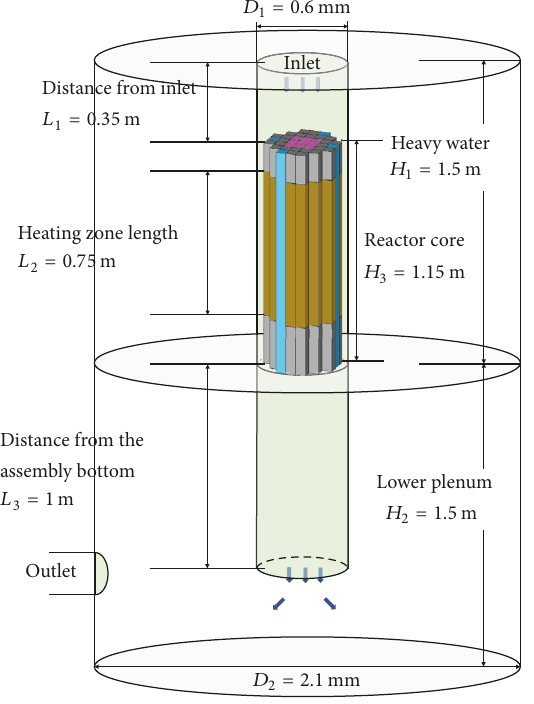
Figure 2: HFRR reactor